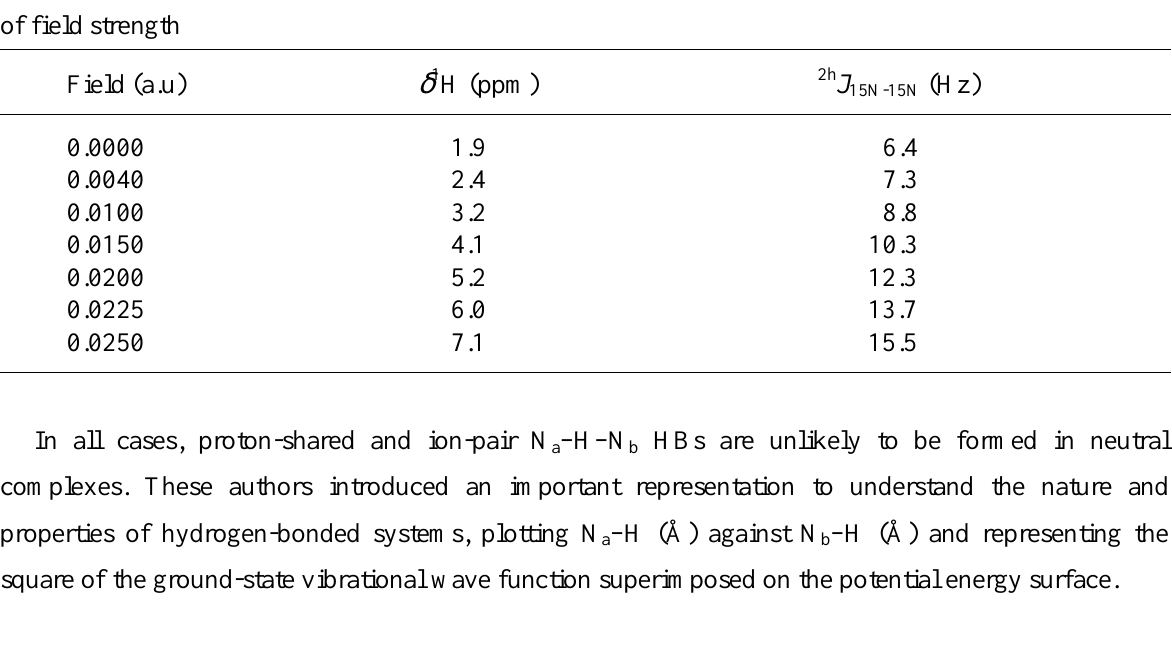
coupling constants as a function 15N-15N